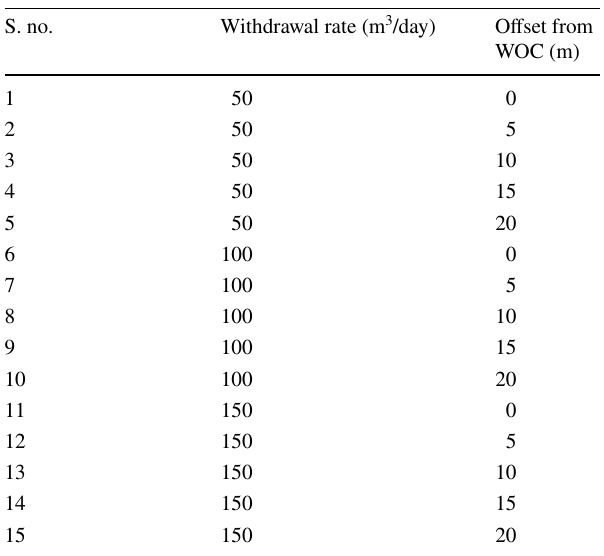
Table 3 Cases examined for vertical well S.